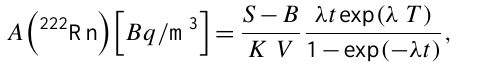
40 km NE from Bratislava.